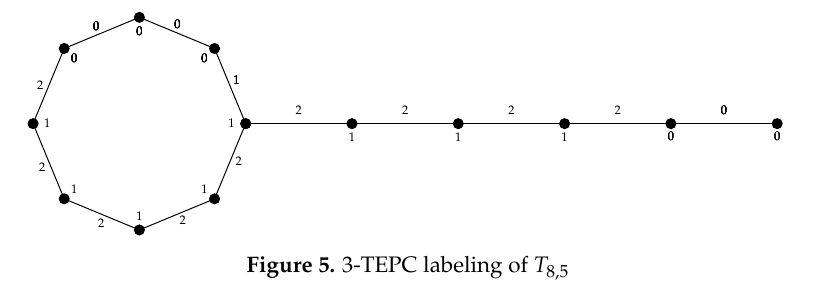
Figure 5. 3-TEPC labeling of T 8,5